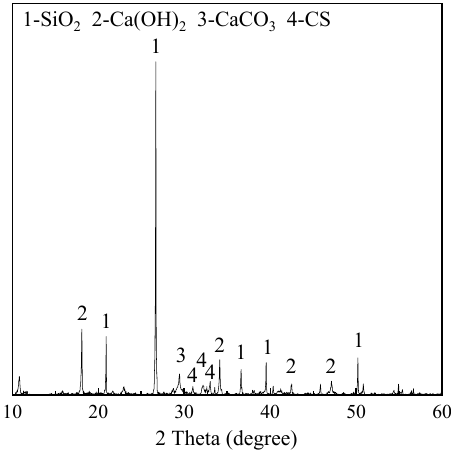
Figure 2. XRD pattern of the slurry.